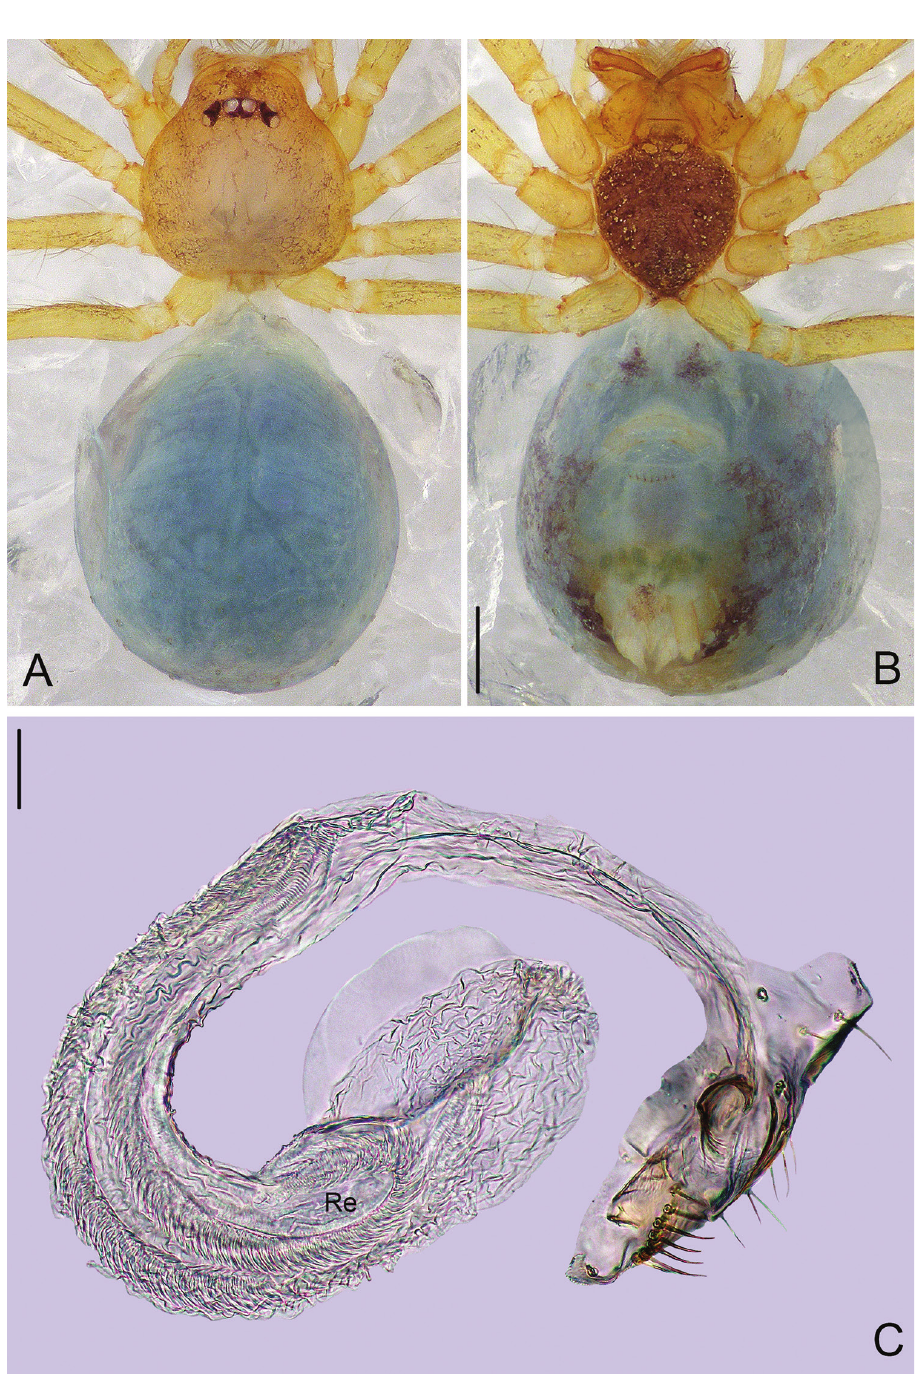
Figure 2. Pinelema cunfengensis sp. n., female paratype. A Habitus, dorsal view B Habitus, ventral view C Vulva, lateral view. Scale bars: 0.2 mm ( A–B ), 0.05 mm ( C